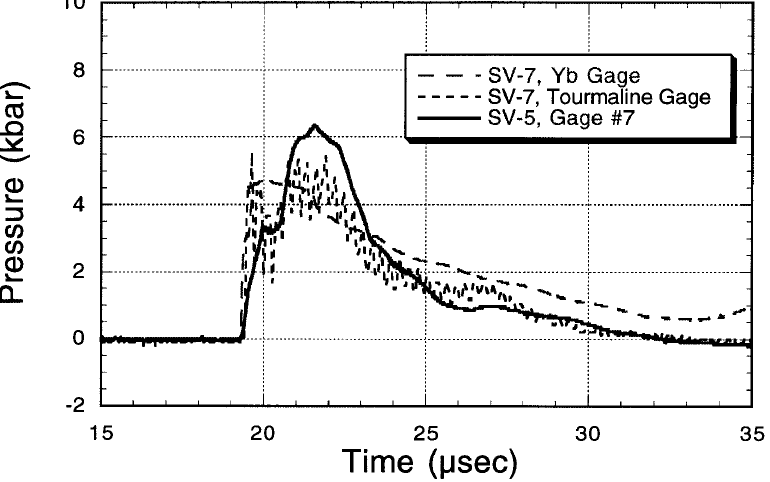
Fig. 5. Comparison of tourmaline gages from shots SV-5 and SV-7 and the Ytterbium gage from Shot